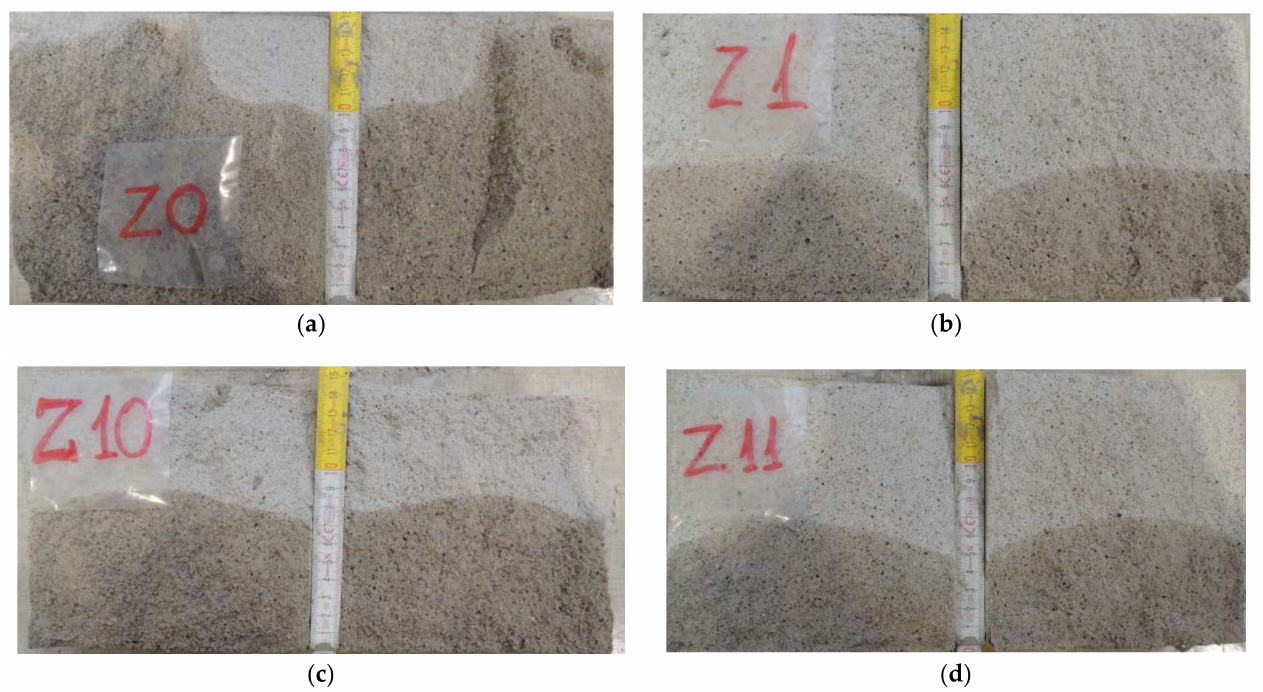
Figure 8. ( a ) Plaster with APA P1. ( b ) Plaster with lime P2. ( c ) Masonry mortar with APA M1. ( d ) Masonry mortar with lime M2. Depth of water penetration as seen and measured on chosen broken